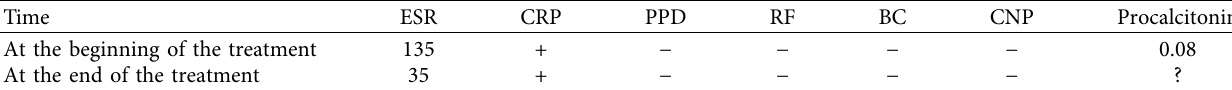
Table 1: The diagnosis test and inflammatory